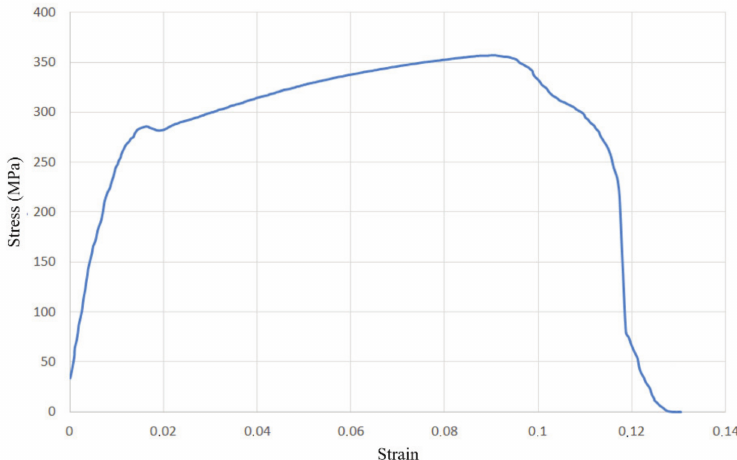
Figure 18. Stress–strain curve for the group with excess WM, undercut, incomplete root penetration (group IV).